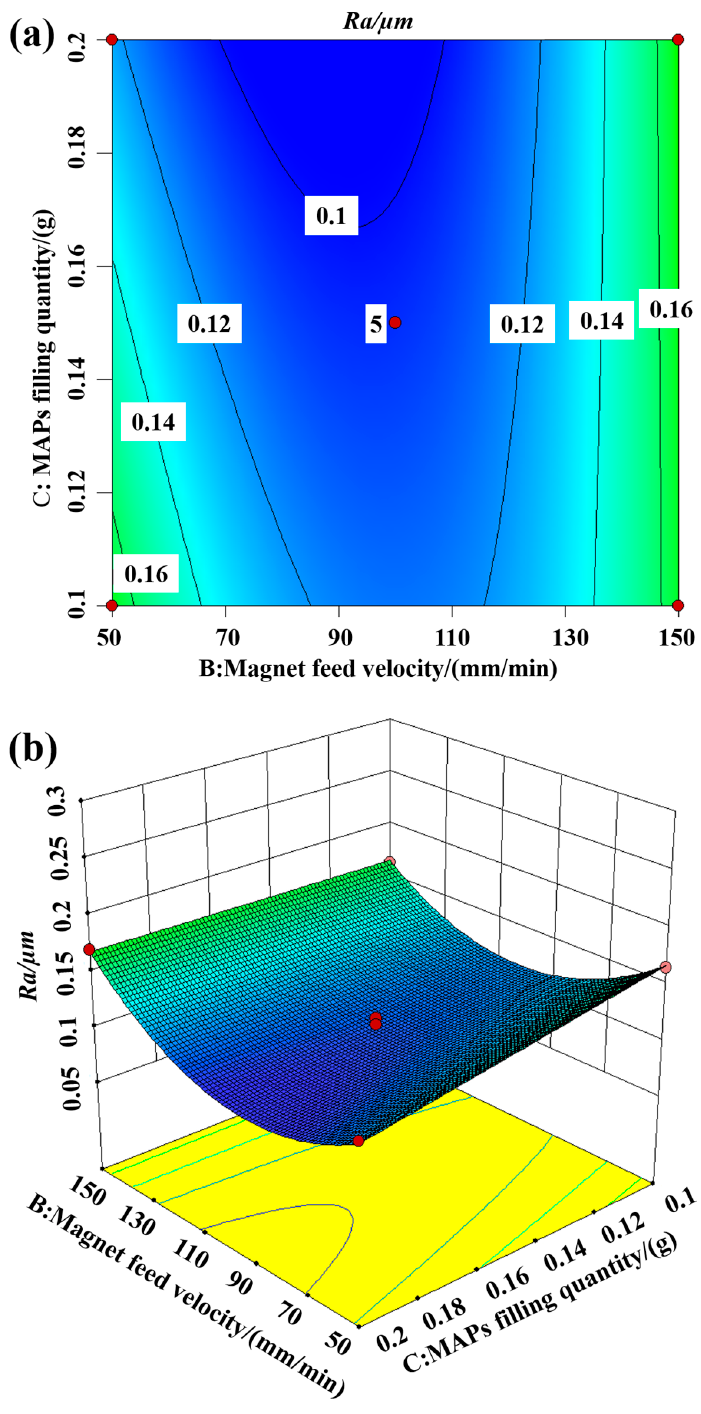
Figure 10. Interaction of magnet feed velocity and MAPs filling quantity on surface roughness: ( a ) contour plot; ( b ) 3D response surface